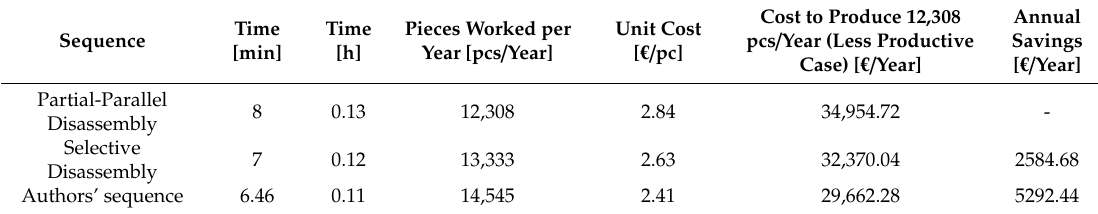
Table 6. Economic